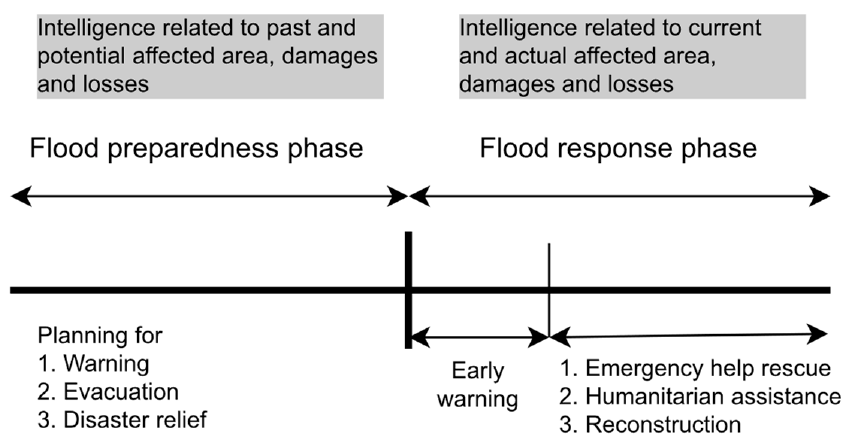
Figure 2. Scope of the intelligence used in the review.